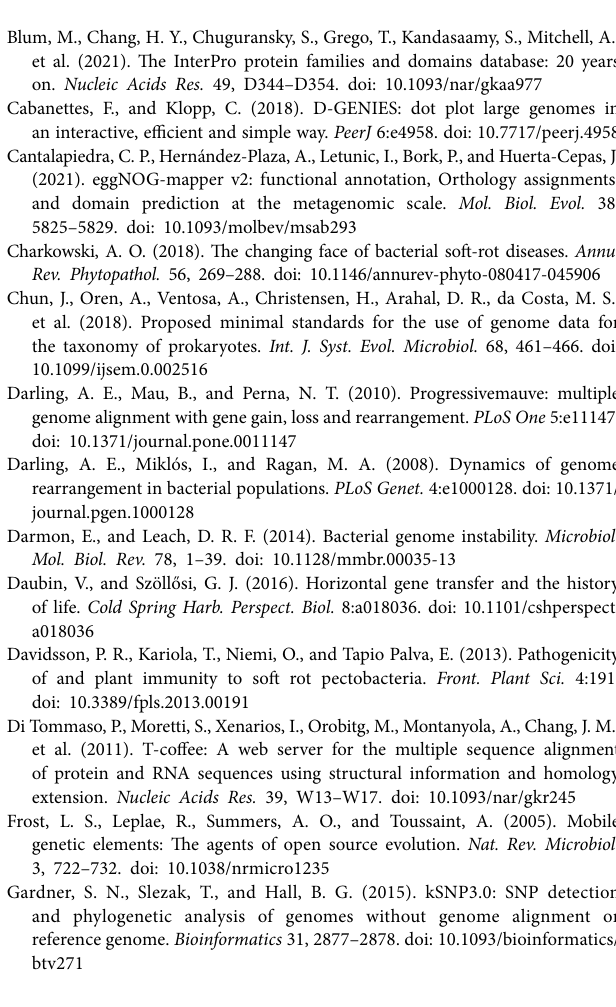
Supplementary Table 1 | Basic information of collected isolates P. aroidearum . Supplementary Table 2 | Basic information for 53 downloaded genomes of Pectobacterium spp. Supplementary Table 3 | Basic statistics of short and long reads. Supplementary Table 8 | The total numbers of each gene derived from